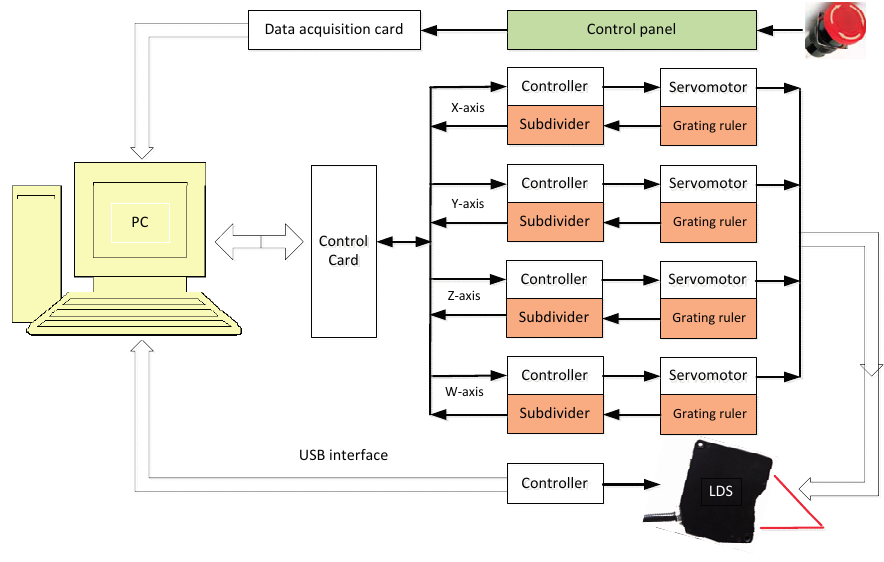
Figure 4. Measurement system control